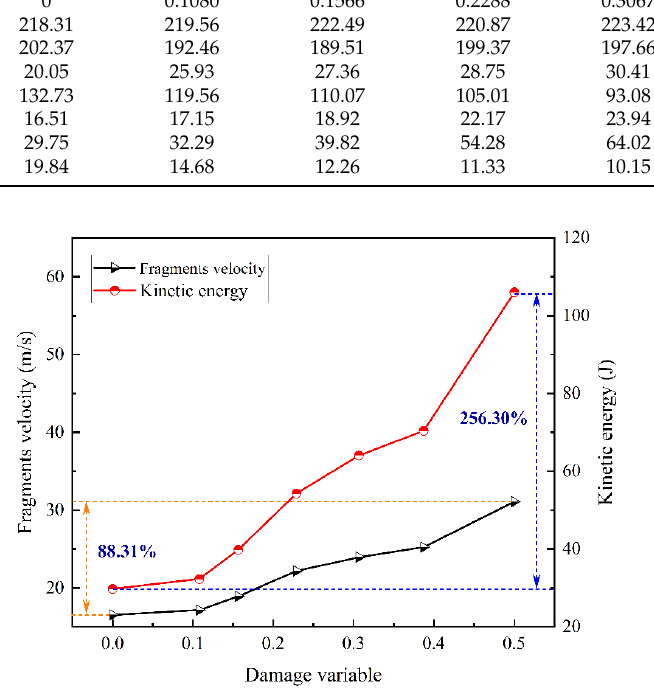
Figure 17. Variation of fragments velocity and kinetic energy with accumulated damage variable.